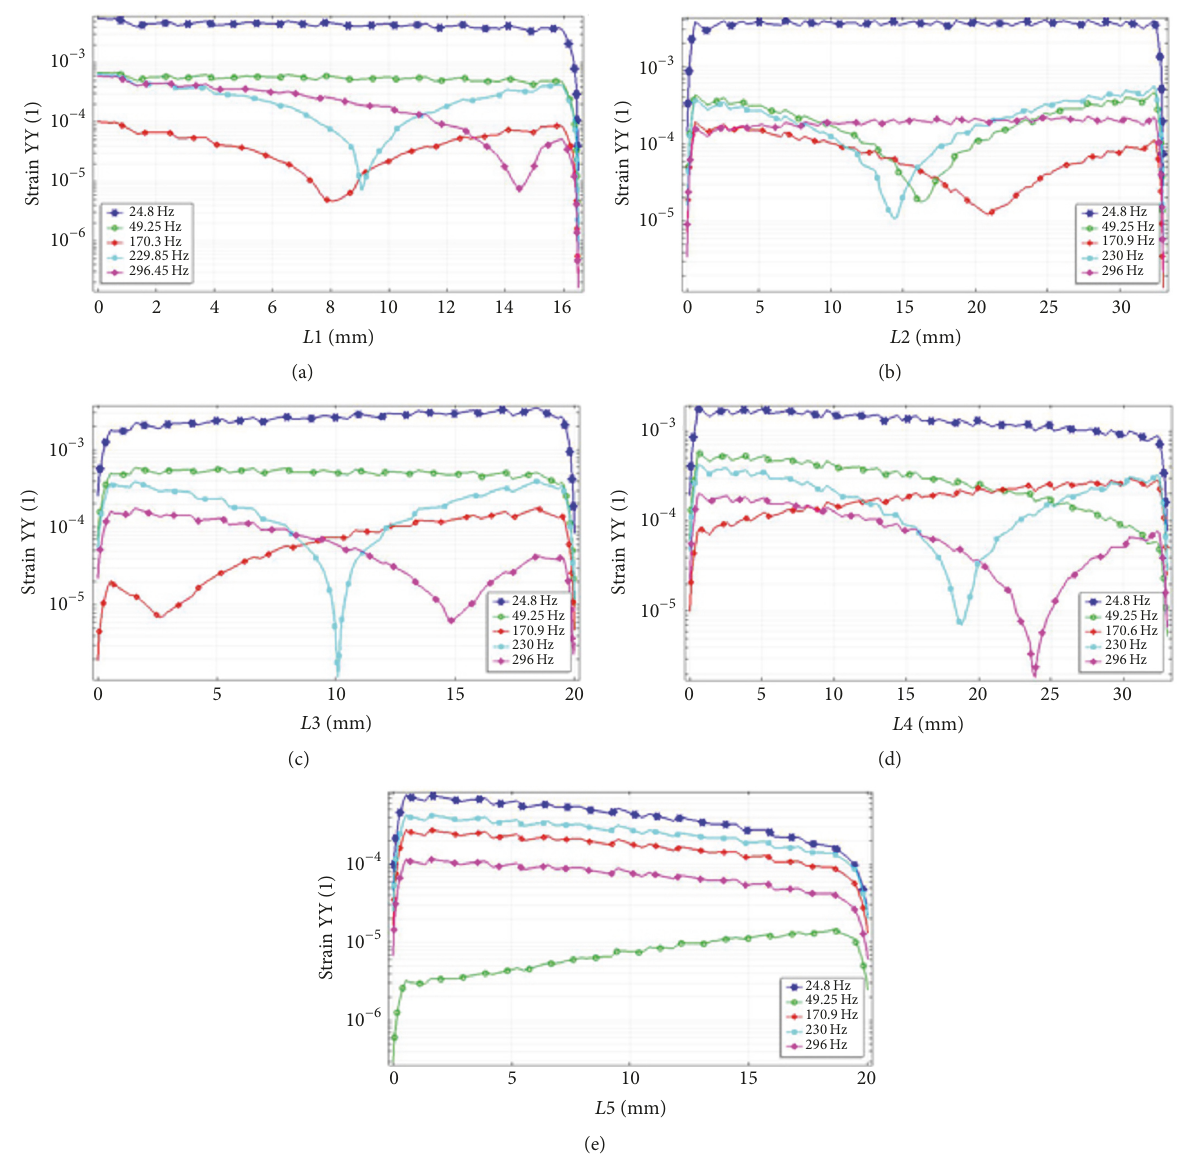
Figure 5: Strain characteristics; (a) strain characteristics at 𝐿 1 ; (b) strain characteristics at 𝐿 2 ; (c) strain characteristics at 𝐿 3 ; (d) strain characteristics at 𝐿 4 ; (e) strain characteristics at 𝐿 5 .